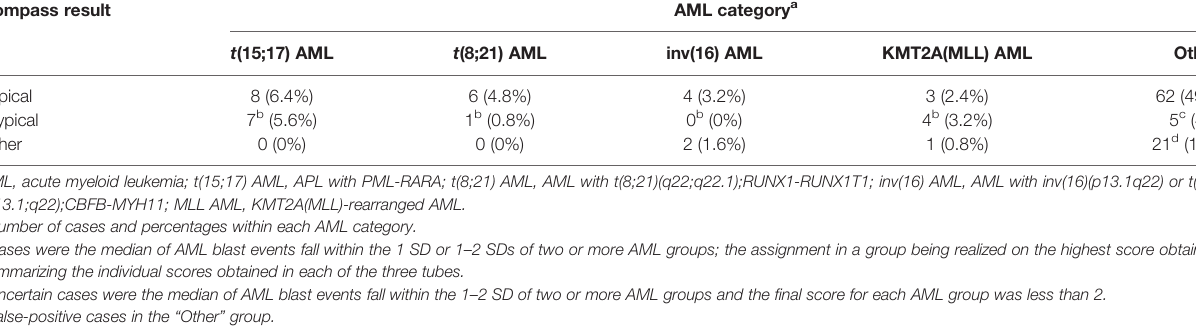
TABLE 2 | Results of the database-guided analysis per AML category. Compass result